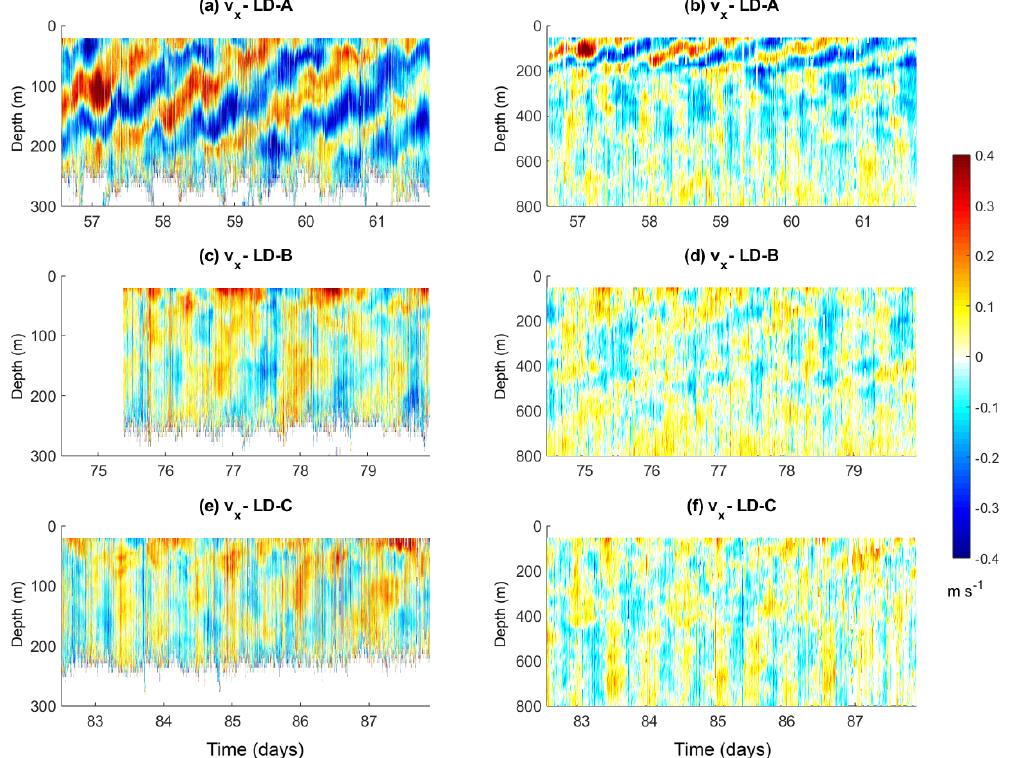
Figure 8. Zonal velocity (ms − 1 ) as a function of time and depth at the long-duration stations; each row from 1 to 3 corresponds to LD-A, LD-B, and LD-C respectively. In the first column ship ADCP data from the 150kHz instrument down to 300m are displayed and in the second column those from the 38kHz instrument down to 800m. Note that in (b) the 150kHz SADCP functioned only a few hours after the beginning of the station